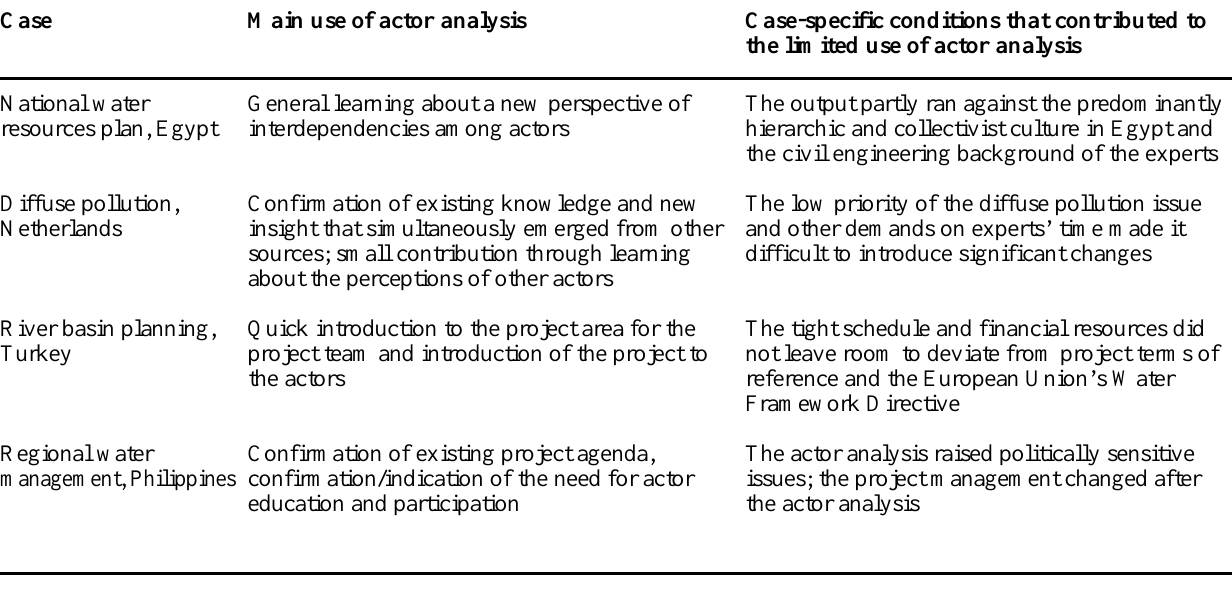
Table 5. Main uses and explanatory conditions for the limited use of actor analysis.